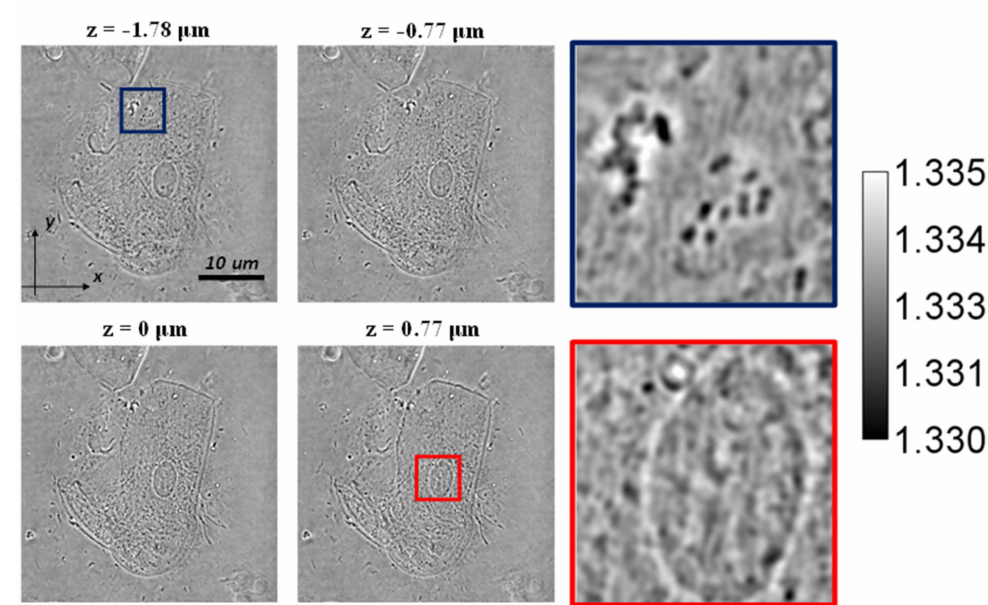
Figure 8. 3D RI reconstruction for misaligned LED ring. As shown in the red box, the contrast is highly suppressed as a result of the cancelation of the low spatial frequency due to the overlap between the two circles in some of the projections. On the other hand, as shown in the dark blue box, we see an artifact where the contrast is inverted for the bacterial structure, which does not agree with the literature [17,31], where the bacterial structures have higher refractive index than